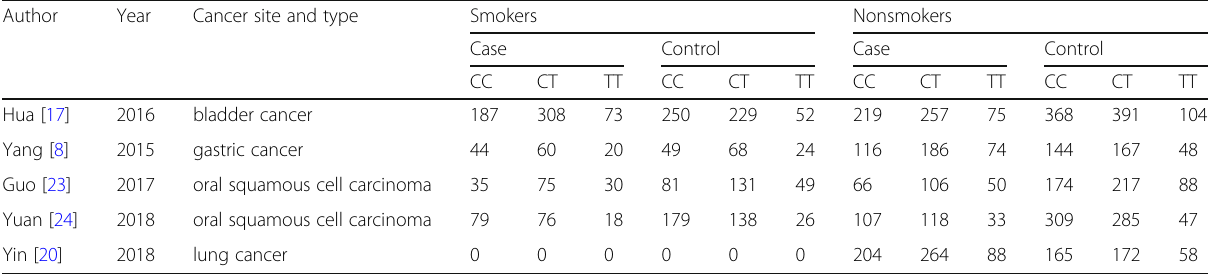
Table 2 Smoking status: characteristics of studies included in the meta-analysis